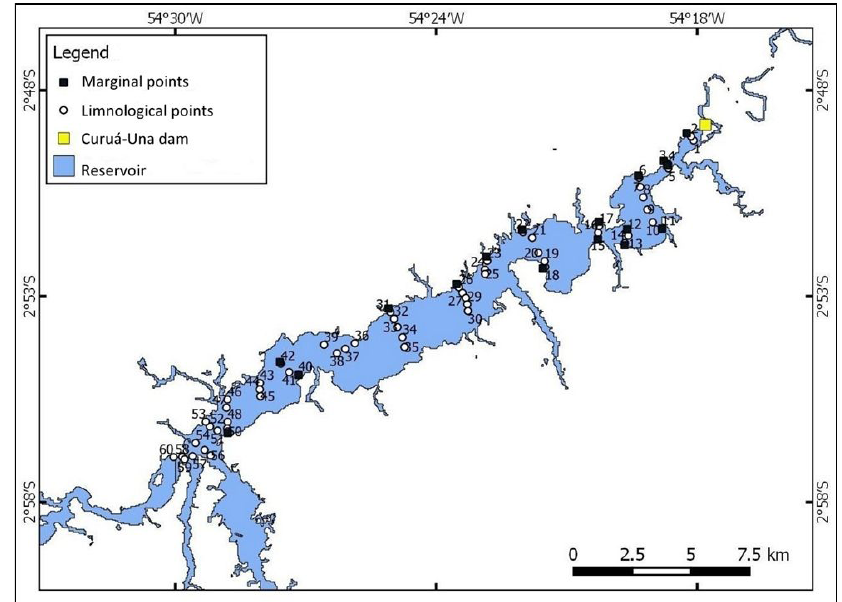
Figure 2. Locations of the sampling points in the Curuá-Una HPP reservoir. Source: Water Geoinformation Laboratory –